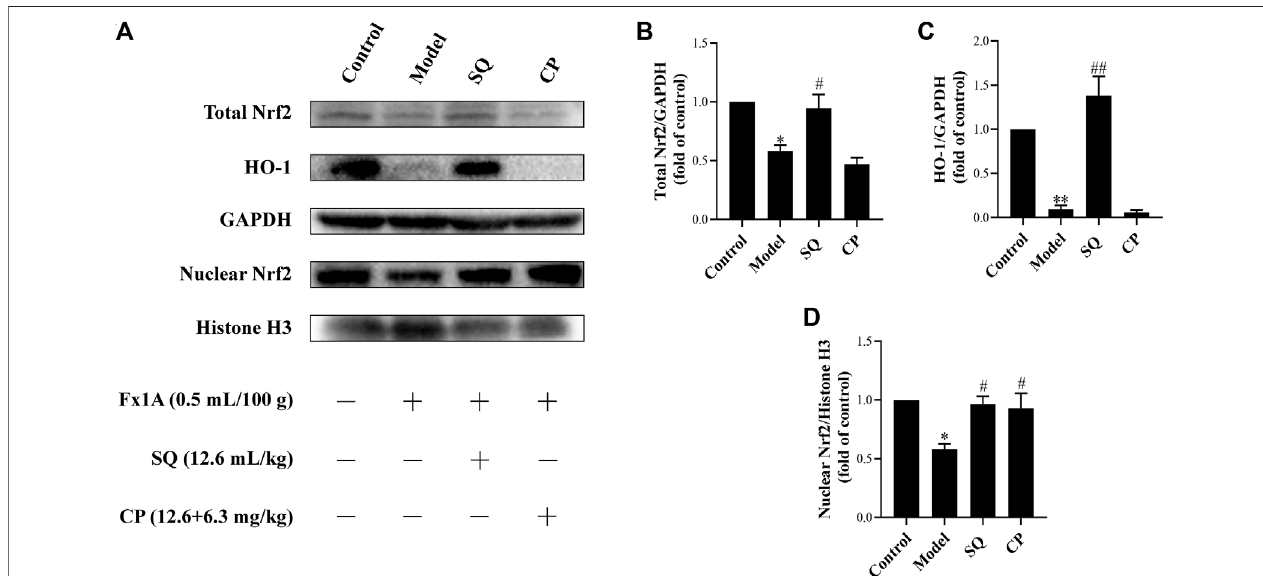
FIGURE6| SQreversedtherepression oftheNrf2/HO-1pathway inglomeruliofPHNrats.TheproteinlevelsoftotalNrf2,nuclearNrf2,andHO-1ineachgroupof theratkidneys weredetected byWesternblot (A) .SQintervention increasedtheproteinexpressions oftotal Nrf2 (B) ,HO-1 (C) ,andnuclearNrf2 (D) inPHNrats( n (cid:1) 3). Data are represented as mean ± SD from independent groups. * p < 0.05 vs. Control group. ** p < 0.01 vs. Control group. # p < 0.01 vs. Model group. ## p < 0.01 vs. Model